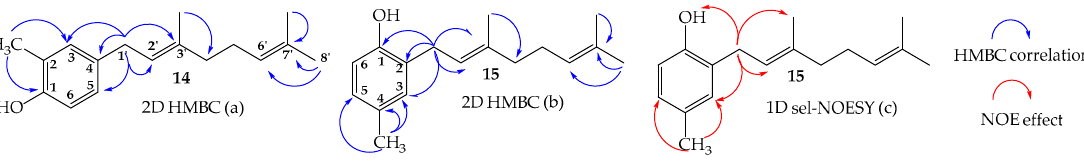
Figure 3. Main observed correlations: 2D Heteronuclear Multiple Bond Correlation (HMBC), Compound 14 ( a ) and Compound 15 ( b ); 1D Nuclear Overhauser Effect Spectroscopy (NOESY) Compound 15 ( c ).